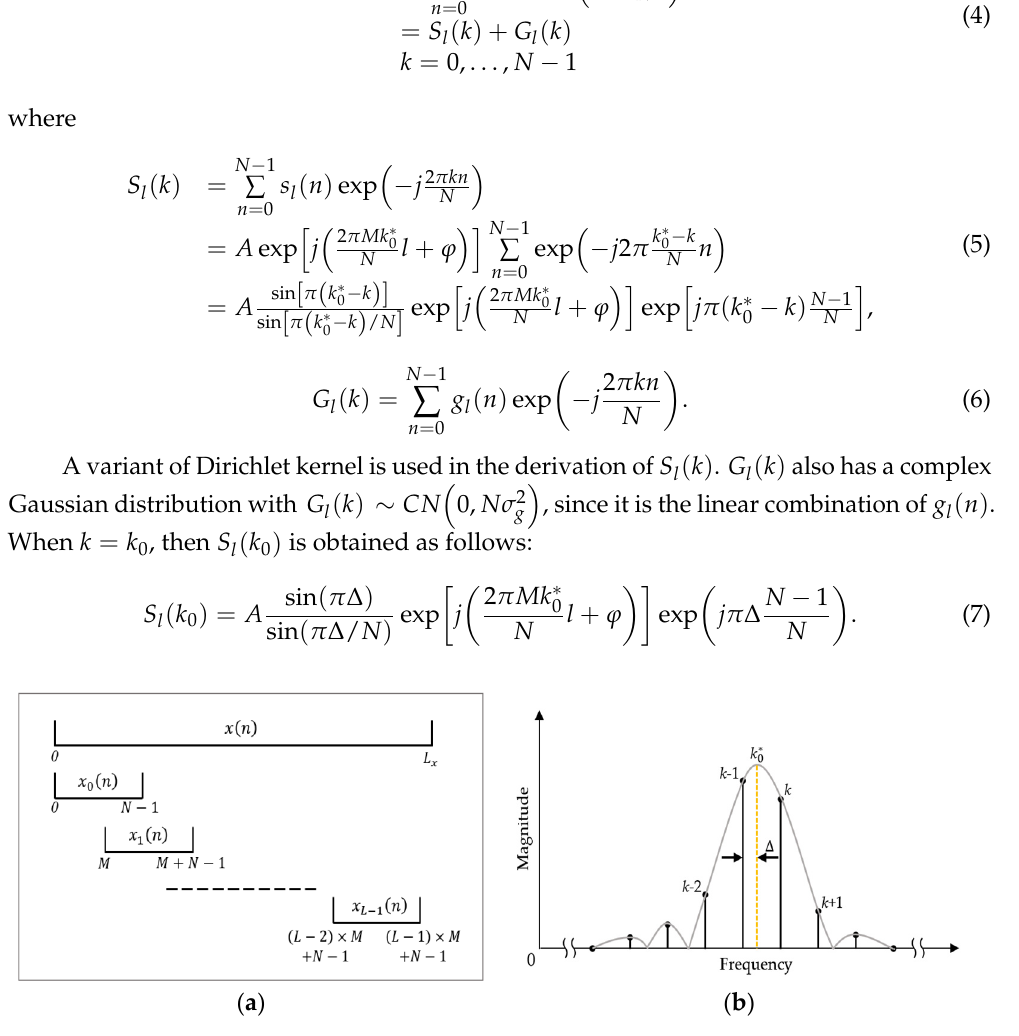
Figure 1. Illustration of the model: ( a ) Segmentation of observe sequence. ( b ) Relationship among 𝑘 , 𝑘 (cid:2868) , 𝑘 (cid:2868)∗ and ∆ ; 𝑘 (cid:2868) = 𝑘 − 1 when 𝑘 (cid:2868)∗ is closer to 𝑘 − 1 and 𝑘 (cid:2868) = 𝑘 + 1 when 𝑘 (cid:2868)∗ is closer to 𝑘 + 1 .